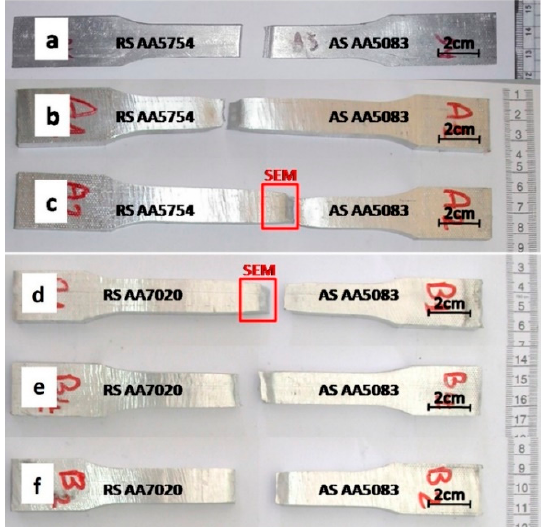
Figure 12. Fracture locations of tensile test specimens of AA5083/AA5754 joints at different welding parameters: ( a ) 400 rpm–20 mm/min, ( b ) 400 rpm–40 mm/min and ( c ) 400 rpm–60 mm/min and fracture locations of AA5083/AA7020 joints at 500 rpm but different travel speeds and positions; ( d ) AA7020 AS-20 mm/min, ( e ) AA7020 AS-40 mm/min and ( f ) AA7020 AS-80 mm/min.